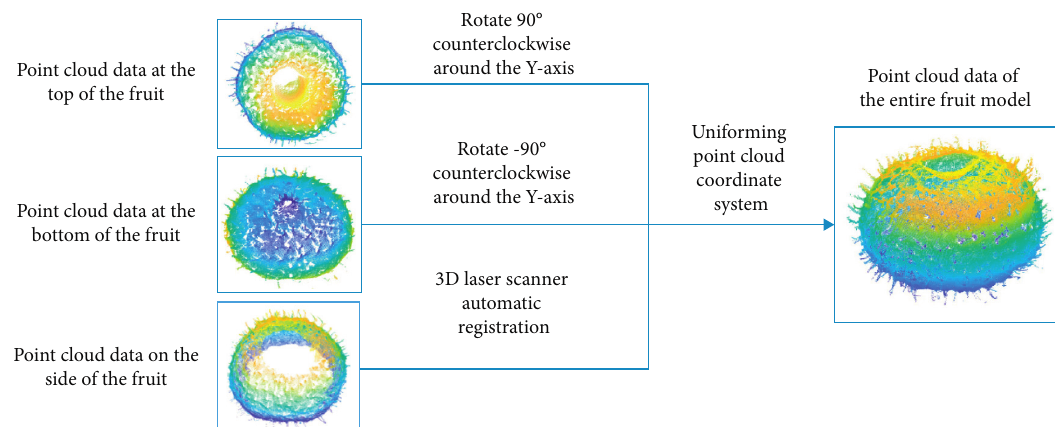
Figure 2: Flowchart of 3D reconstruction of Rosa roxburghii fruit.